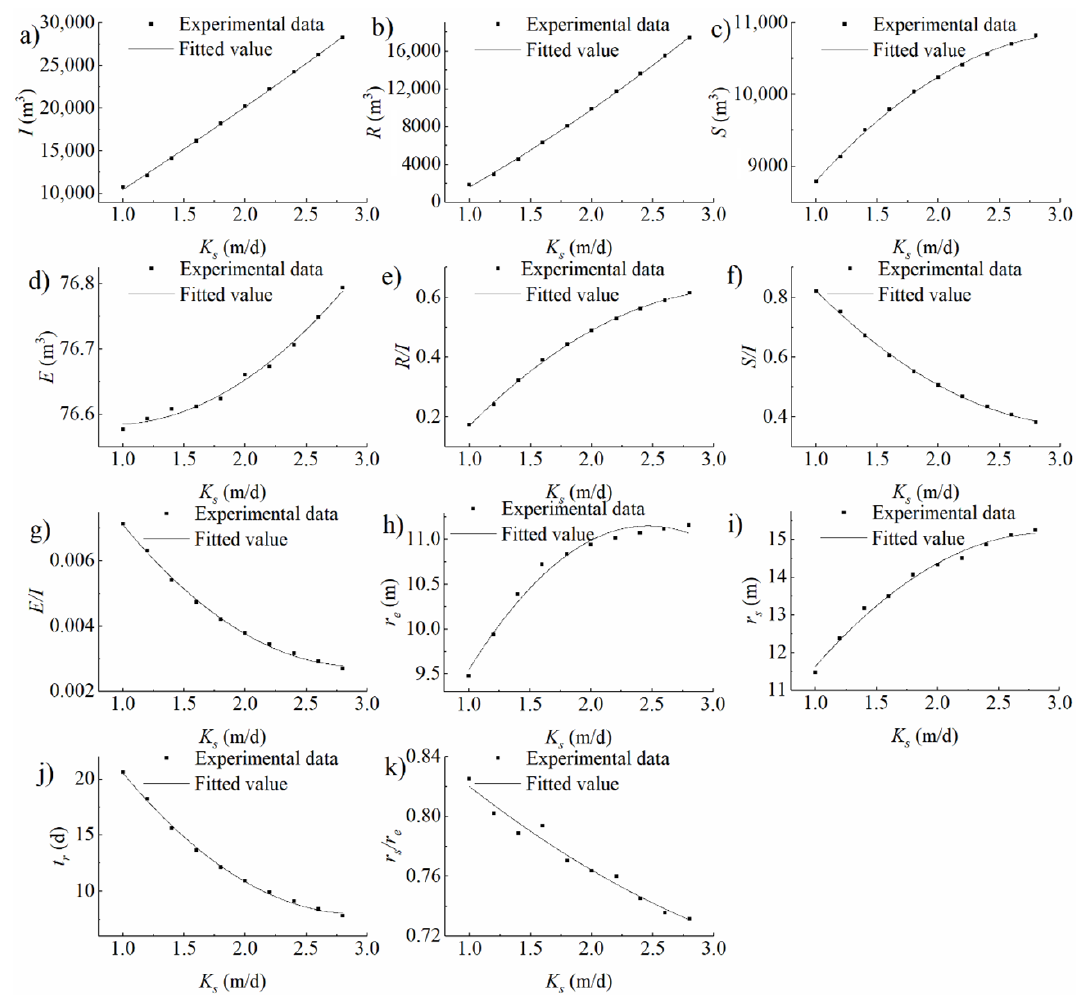
Figure 7. The variations with an increment in K s . (( a ) variation of I; ( b ) variation of R; ( c ) variation of S; ( d ) variation of E; ( e ) variation of R/I; ( f ) variation of S/I; ( g ) variation of E/I; ( h ) variation of r e ; ( i ) variation of r s ; ( j ) variation of t r ; ( k ) variation of r s /r e .).